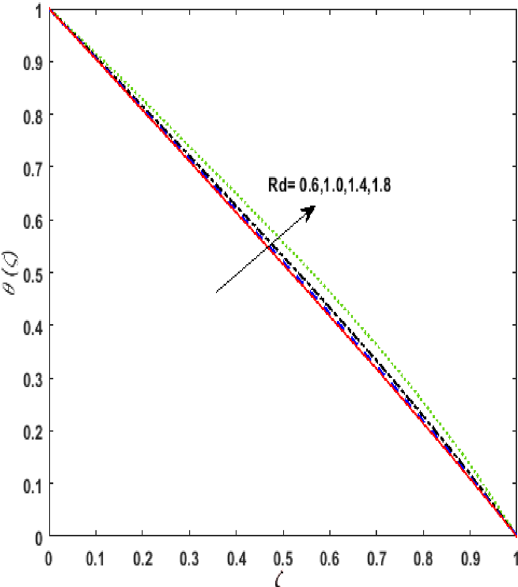
Figure 9. Effect of Radiation parameter Rd on temperature θ(ζ) .